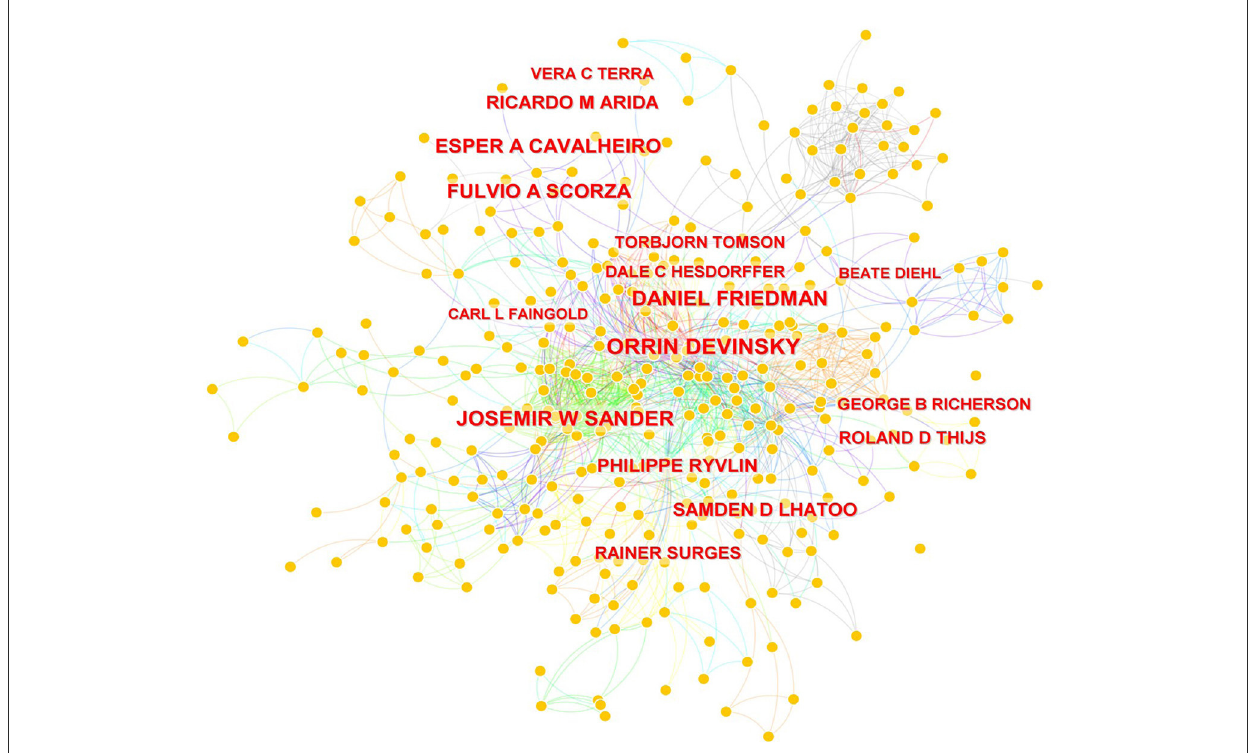
FIGURE5 Network map of active authors contributing to SUDEP